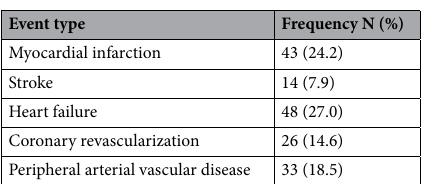
Table 2. Distribution of non-fatal cardiovascular events which occurred during study follow-up.